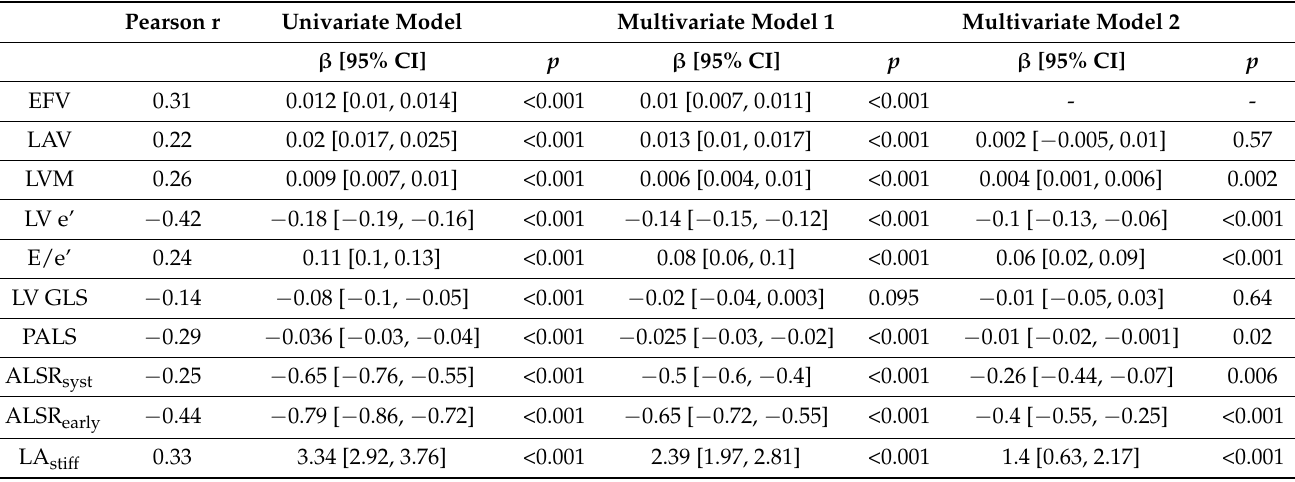
Table 4. Multiple linear regression analysis for association of NAFLD Fibrosis Score with EFV, diastolic function, and deformation parameters